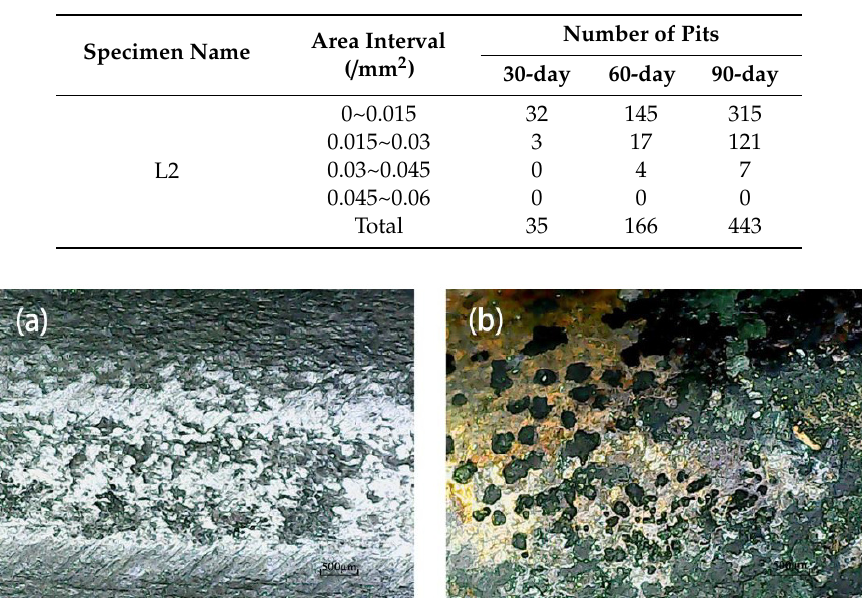
Table 6. Distribution statistics of pitting size of L2.